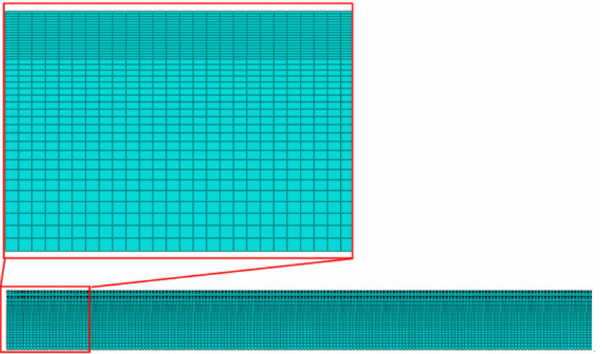
Figure 19. Mesh of the plate in the 2D